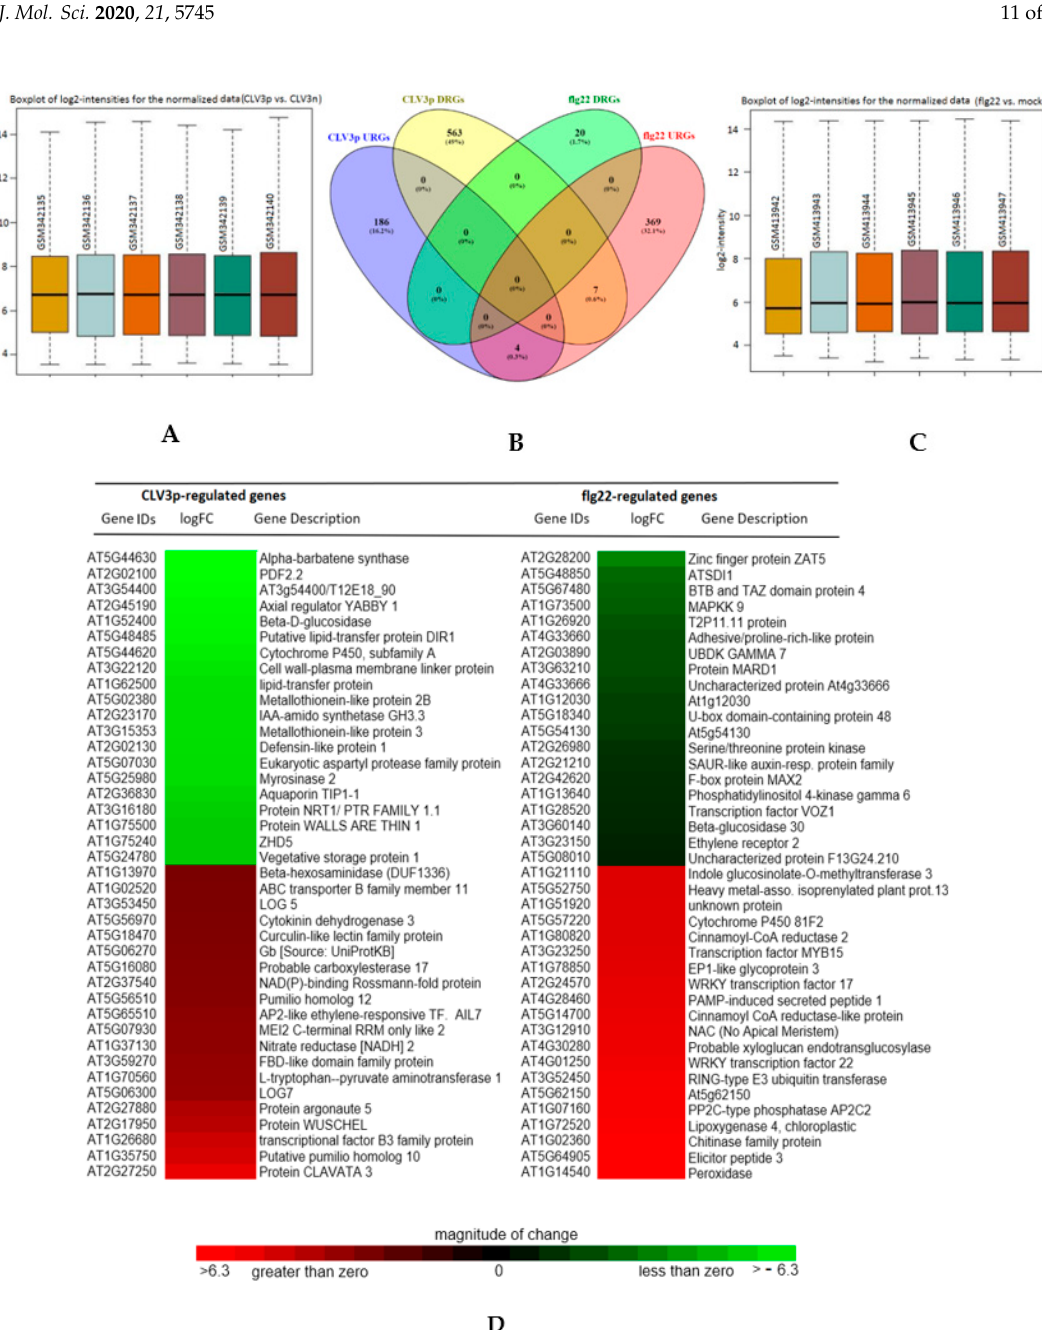
Figure 3. Overlap between the DEGs of CVL3p-expressing cellular populations (stem cells) and flg22-treated mesophyll cells. ( A ) The GEO acquired raw CLV3p- and CLV3n-expressing SAM cellular microarray datasets, 3-replicates each wild type and mutant with its GEO-Samples (GSM)-identifiers, are statistically normalized. ( B ) The Flg22 and CLV3p regulated differentially expressed genes (DEGs) are compared and contrasted for co-regulated genes in a Venn diagram (http://bioinfogp.cnb.csic.es/tools/venny/). ( C ) The raw microarray datasets pertaining the flag22-treated mesophyll cells and mock-treated mesophyll cells were also acquired from GEO and then normalized. ( D ) Top-20 up- and down-regulated differentially expressed genes from both CLV3p-expressing SAM cell populations (A: left panel) and flg22-treated mesophyll cells (C: right panel) are visualized with the Heatmapper plus tool (http://bar.utoronto.ca/ntools/cgi-bin/ntools_heatmapper_plus.cgi) of the ePlant database. The column information deals with the gene IDs, logFC in term of heatmap, and the annotation of the given genes. The scale bar beneath the columns denotes the magnitude of both up-regulation (red) and down-regulation (green) for the given genes.